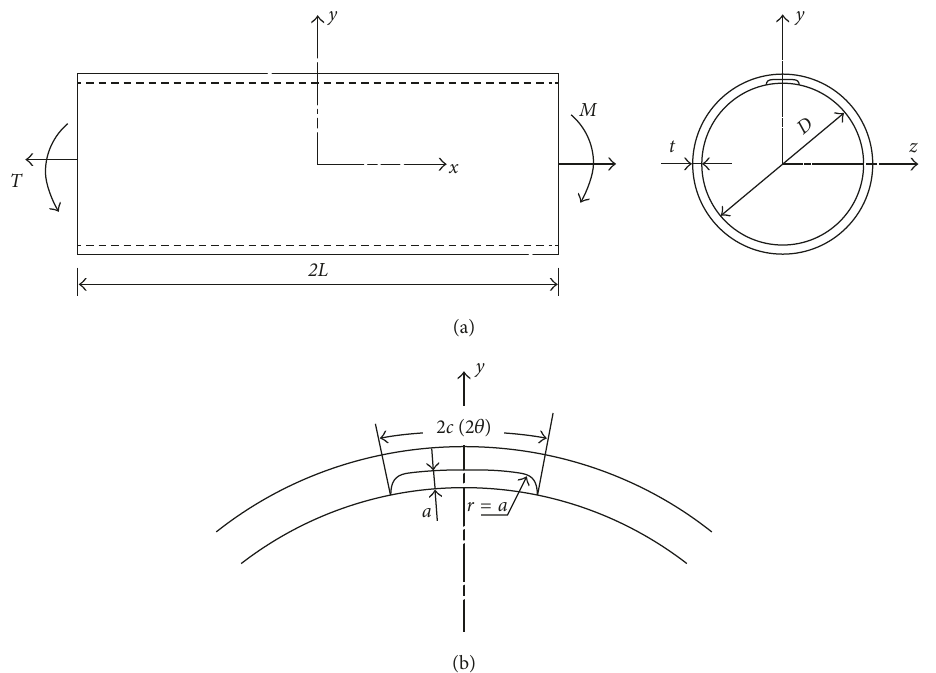
Figure 1: (a) The geometrical dimension of the pipe with a circumferential surface crack. (b) Geometry of the surface